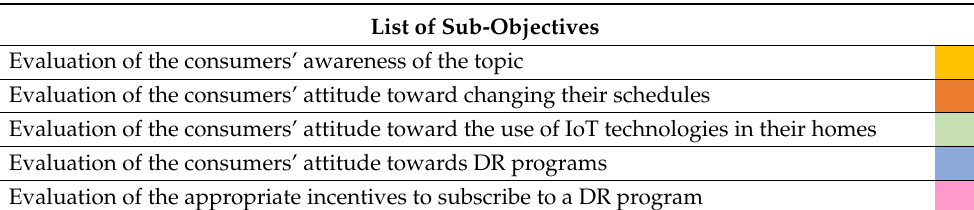
Table 1. List of sub-objectives of the questionnaire and colour legend. A colour is assigned to each sub-objective in order to refer to them in the other tables of the